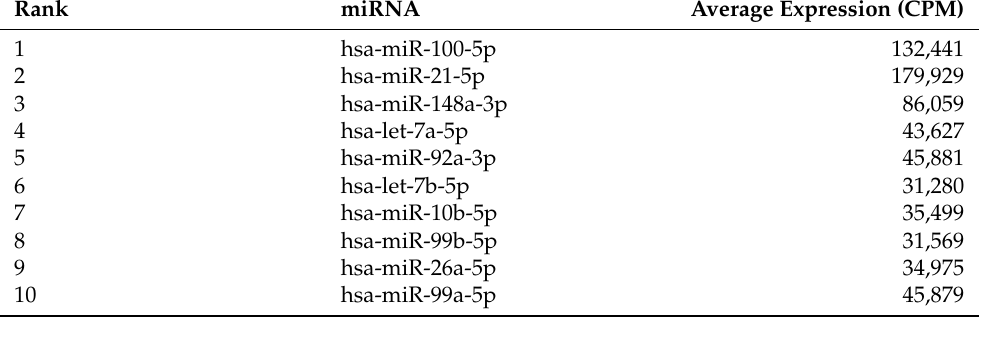
Table 2. Highest-ranked SF EV miRNAs across the entire patient cohort.